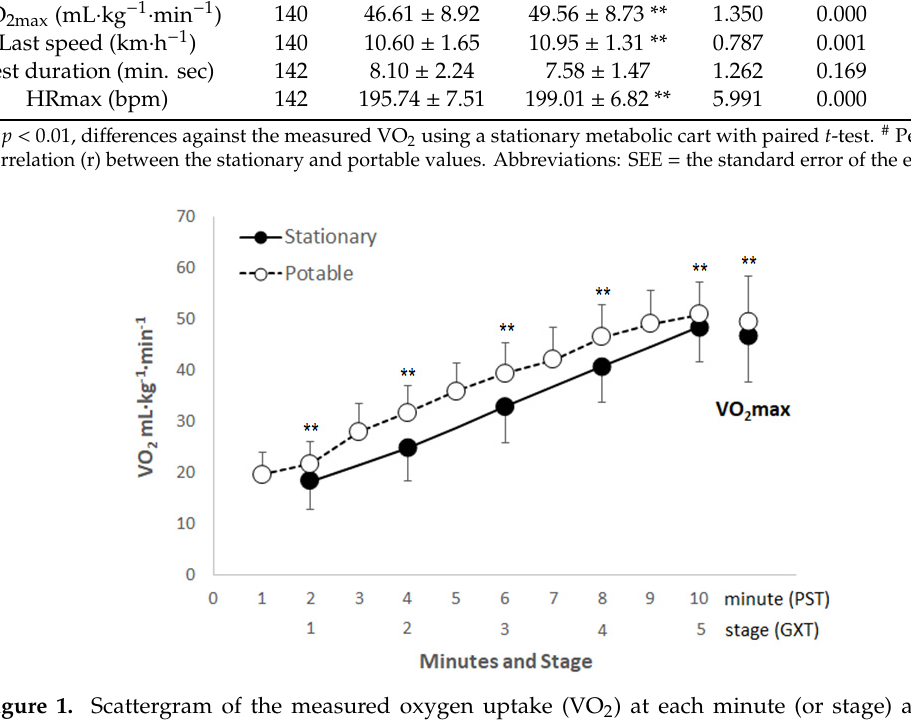
Table 3. Comparison of measured VO 2max between stationary and potable gas analyzers.